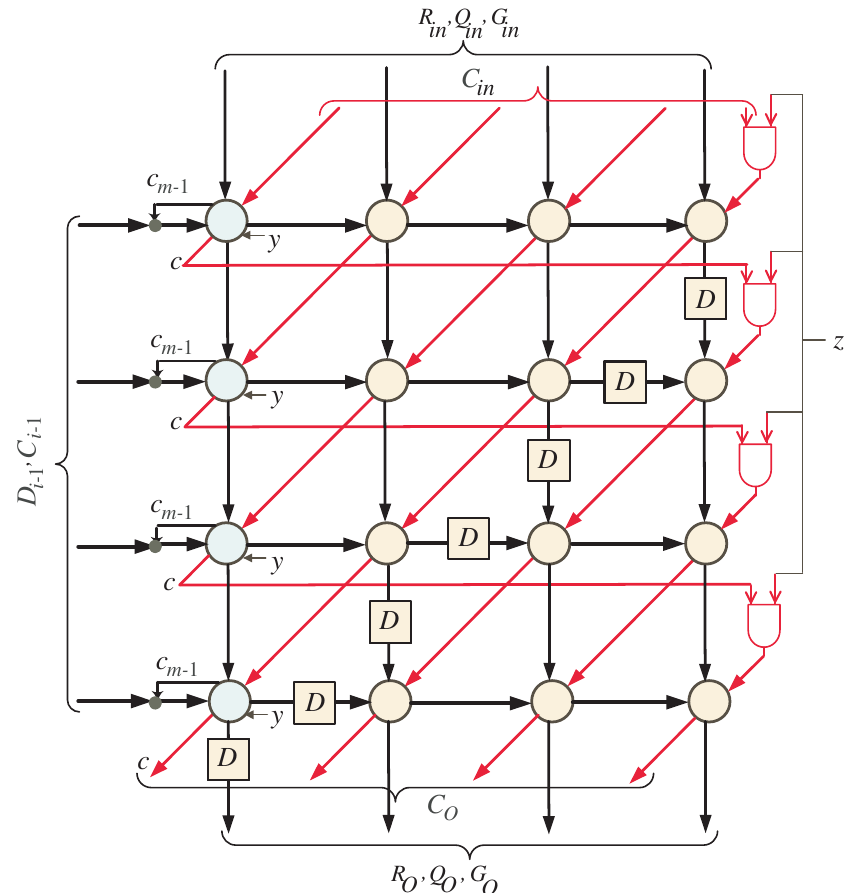
Figure 6. Word-based two-dimensional SISO systolic